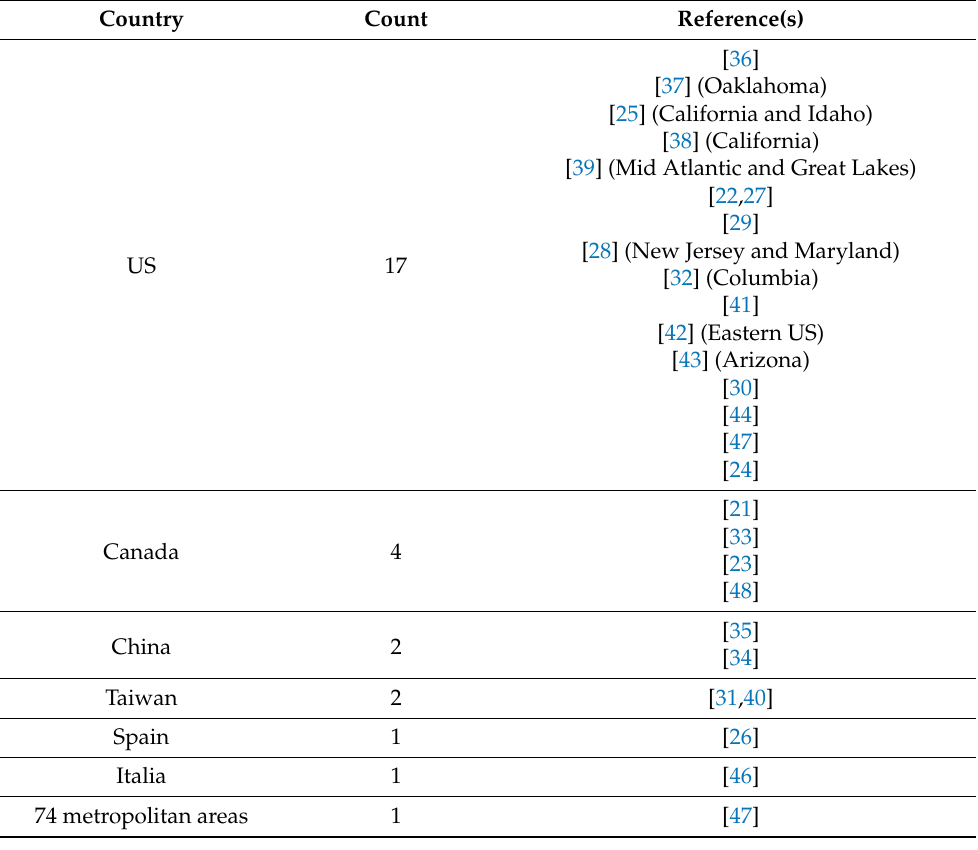
Table 3. Countries covered in existing studies (source: own elaboration).